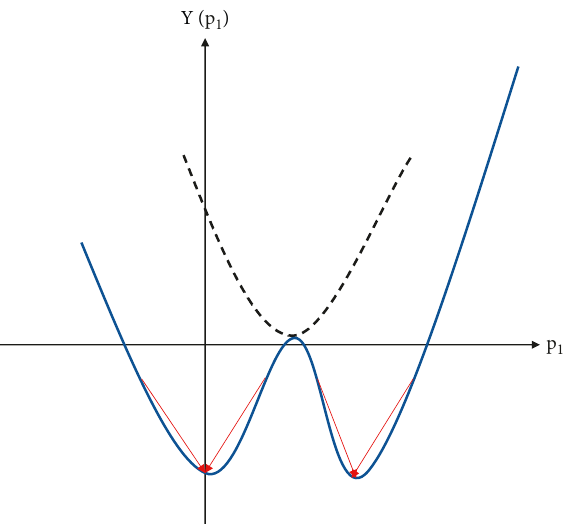
Figure 7: Potential function in the second